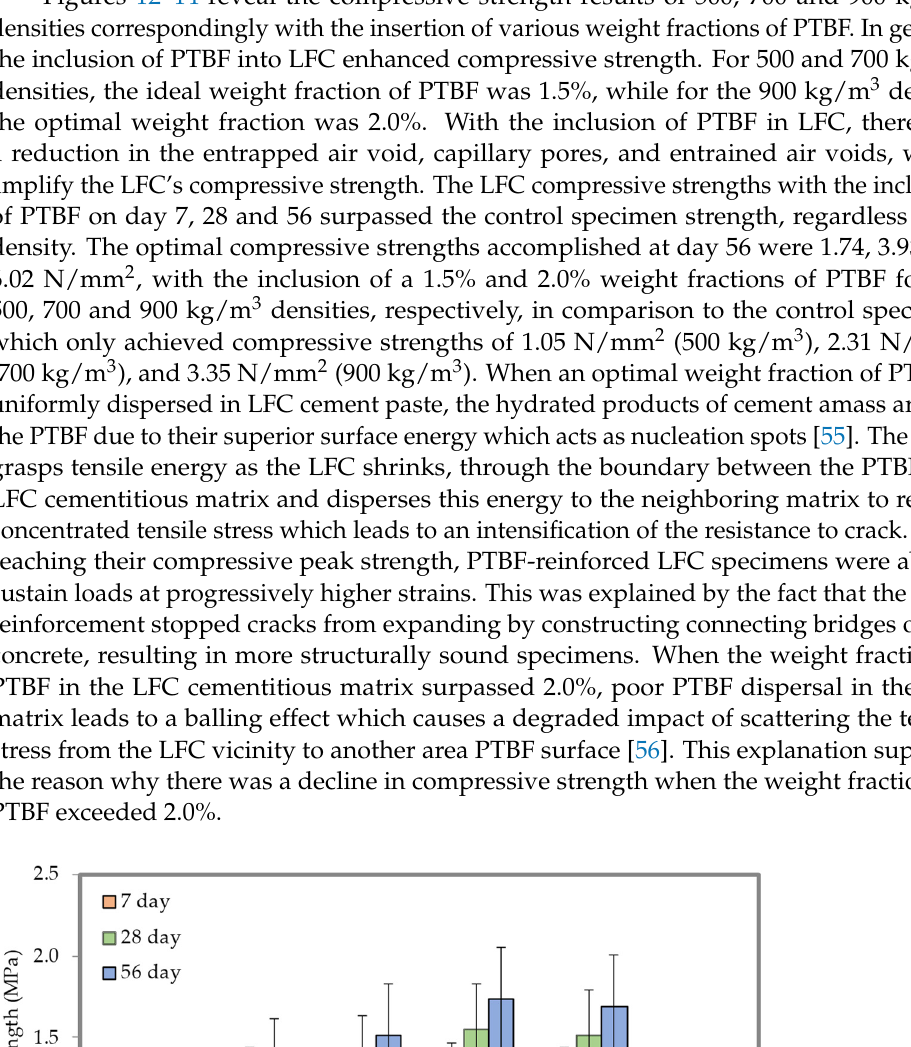
Figure 13. Compressive strength of 700 kg/m 3 density LFC with different weight fractions of PTBF. Figure 14. Compressive strength of 900 kg/m 3 density LFC with different weight fractions of PTBF.